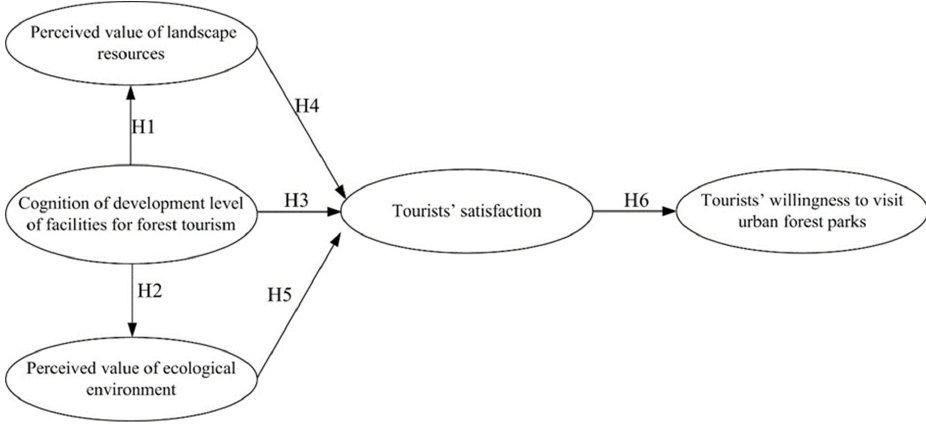
Figure 1. Theoretical